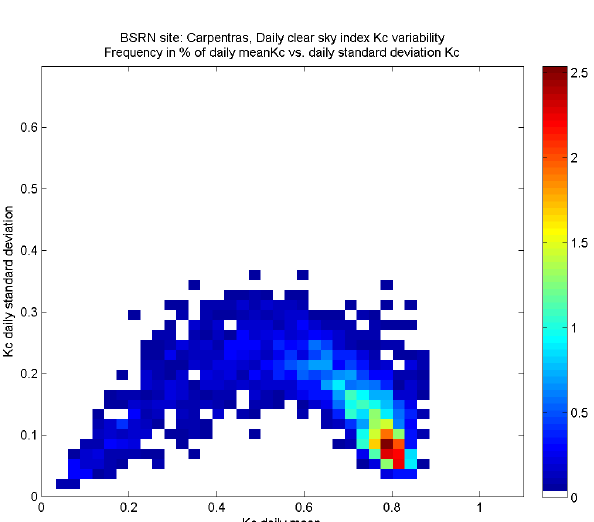
Figure 5. 2-D histogram of the daily mean of Kc on the horizontal axis and the daily standard deviation of Kc on the vertical axis for Carpentras. The frequency in percent is coded in colour with the scale given on the right.